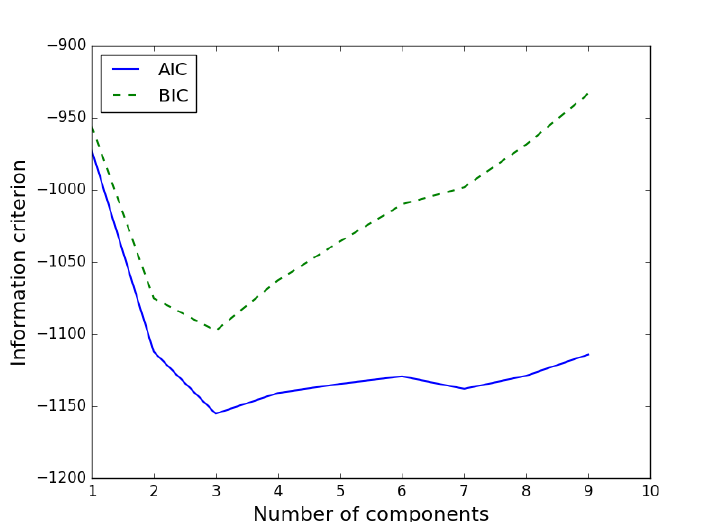
Figure 7. AIC and BIC values for the two dimensional GMM analysis (as a function of log(density) and ESI) over the combined data. Both AIC and BIC attain a minimum value for three components. ∆ AIC = 14 and ∆ BIC = 22, which is significant enough to reject the respective models in favor of our null hypothesis with strong